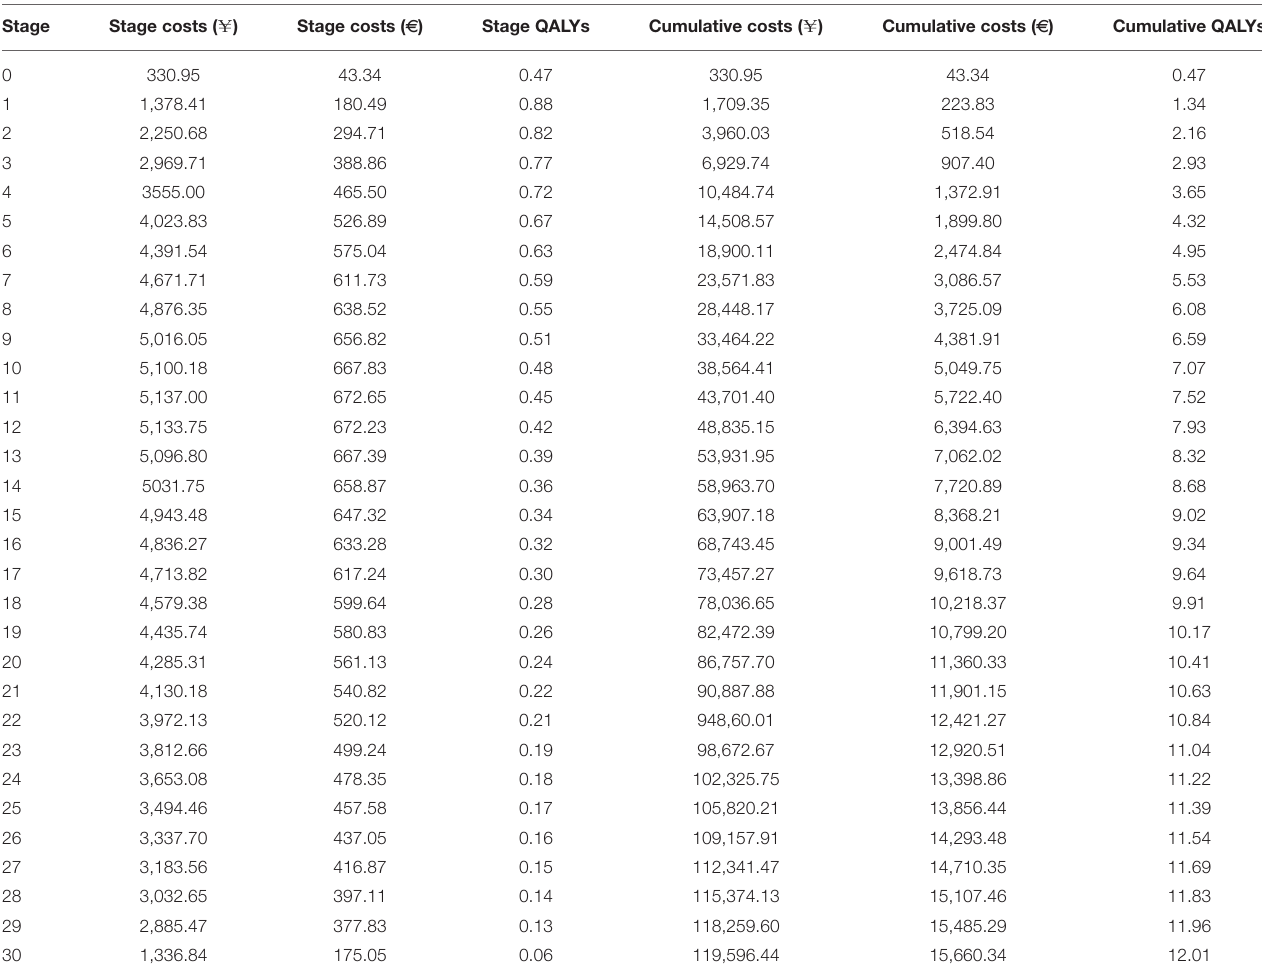
TABLE 6 | Stage costs, stage QALYs, cumulative costs and cumulative QALYs for standard treatment group.